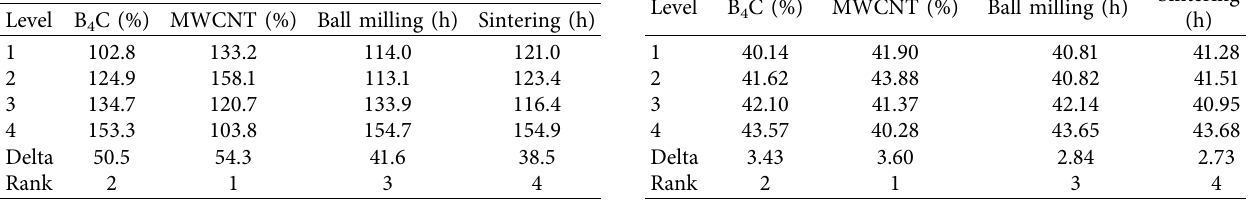
Table 7: Response table for means.